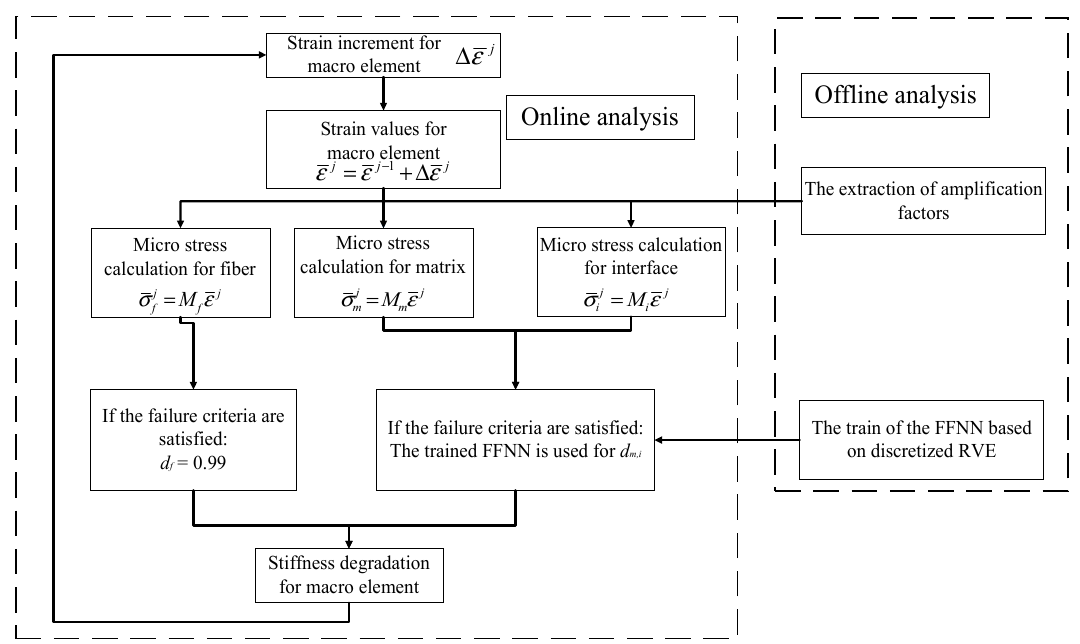
Figure 7. Analysis flow of the modified MMF-based multiscale method.